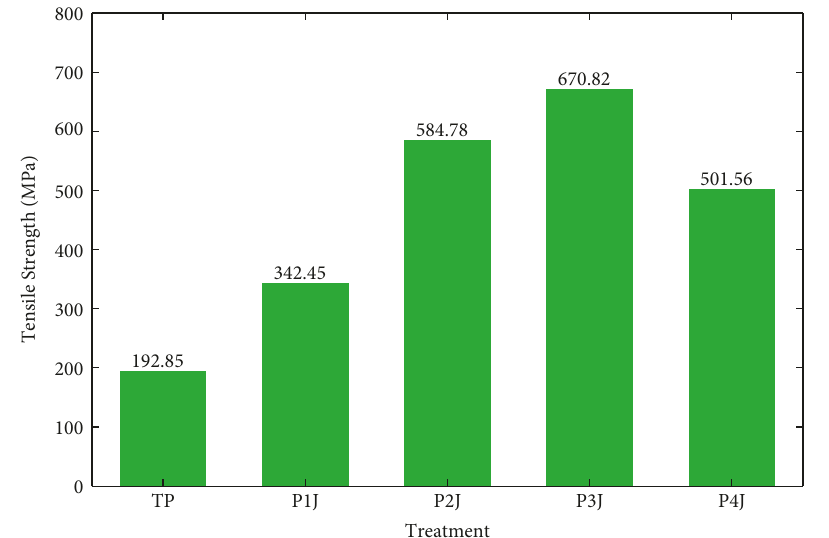
Figure 5: KPLF tensile stress at the base vs. immersion time.